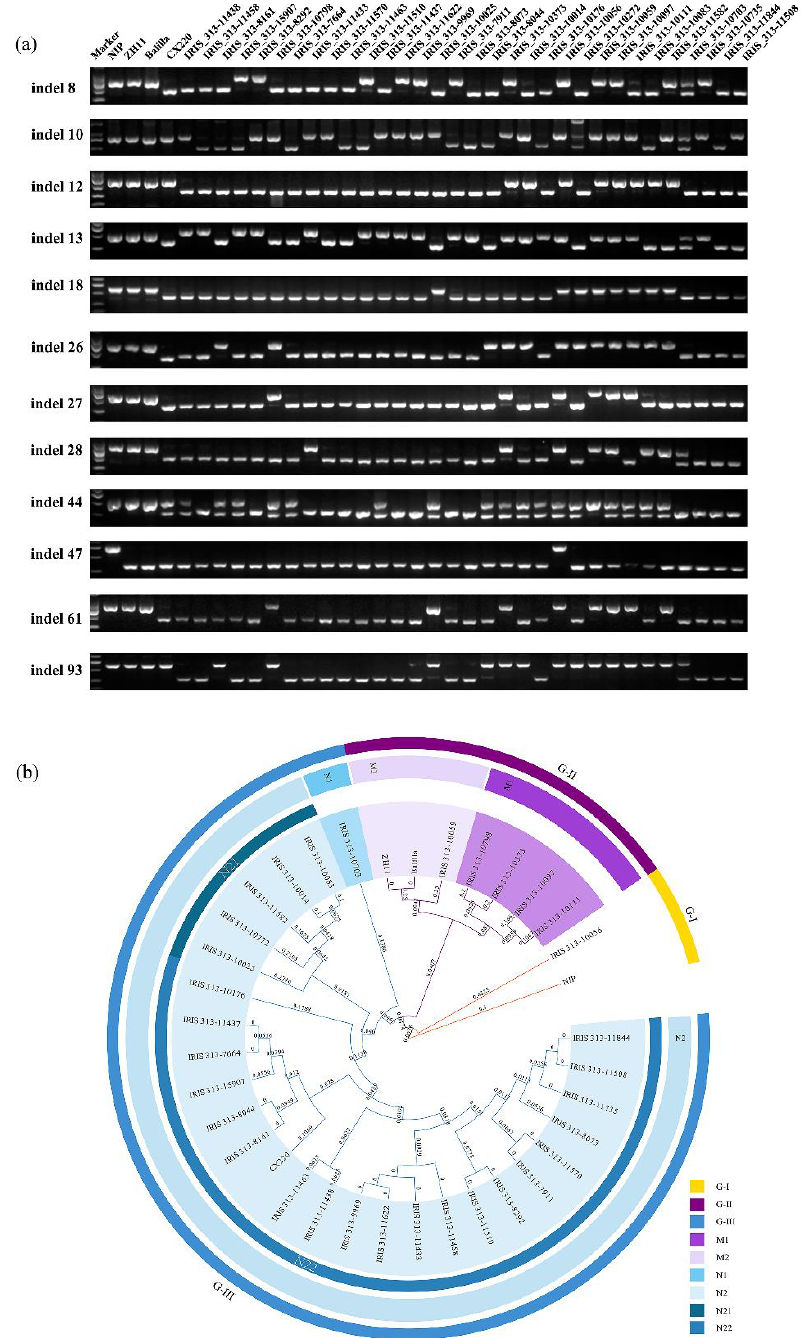
Figure 3. PCR amplification and phylogenetic tree of 36 different japonica rice varieties with the insertion/deletion (InDel). ( a ) PCR amplification and electrophoresis of 36 japonica rice varieties by using the 26 InDel primer pairs. M: DL2000, DNA marker. Nipponbare was used as a control. ( b ) Phylogenetic tree of 36 japonica rice candidate materials by the UPGMA dendrogram using 26 InDel markers. The names of different groups and subgroups are represented by different colours, and numbers in the phylogenetic tree represent evolutionary distances of the tree structure below this node.